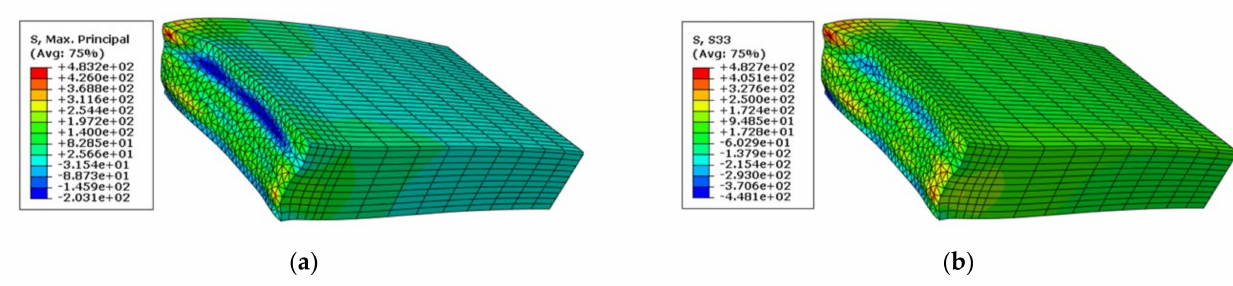
Figure 22. Residual stress distribution in the right part of the specimen shown in Figure 20. ( a ) Max principal stress; ( b ) stress component normal to the cut surface.